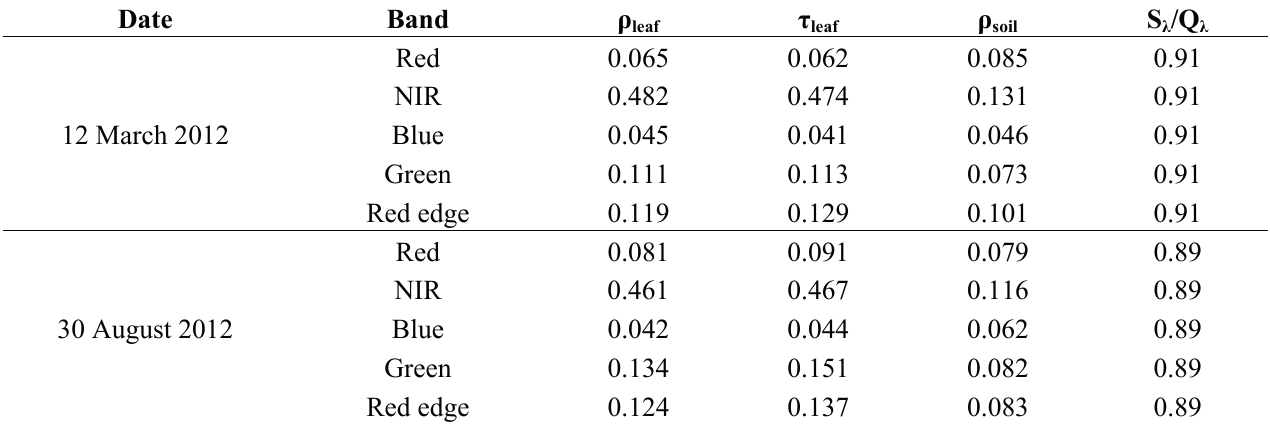
Table 9. Optical parameters used in the 4SAIL-RowCrop model and 4SAIL